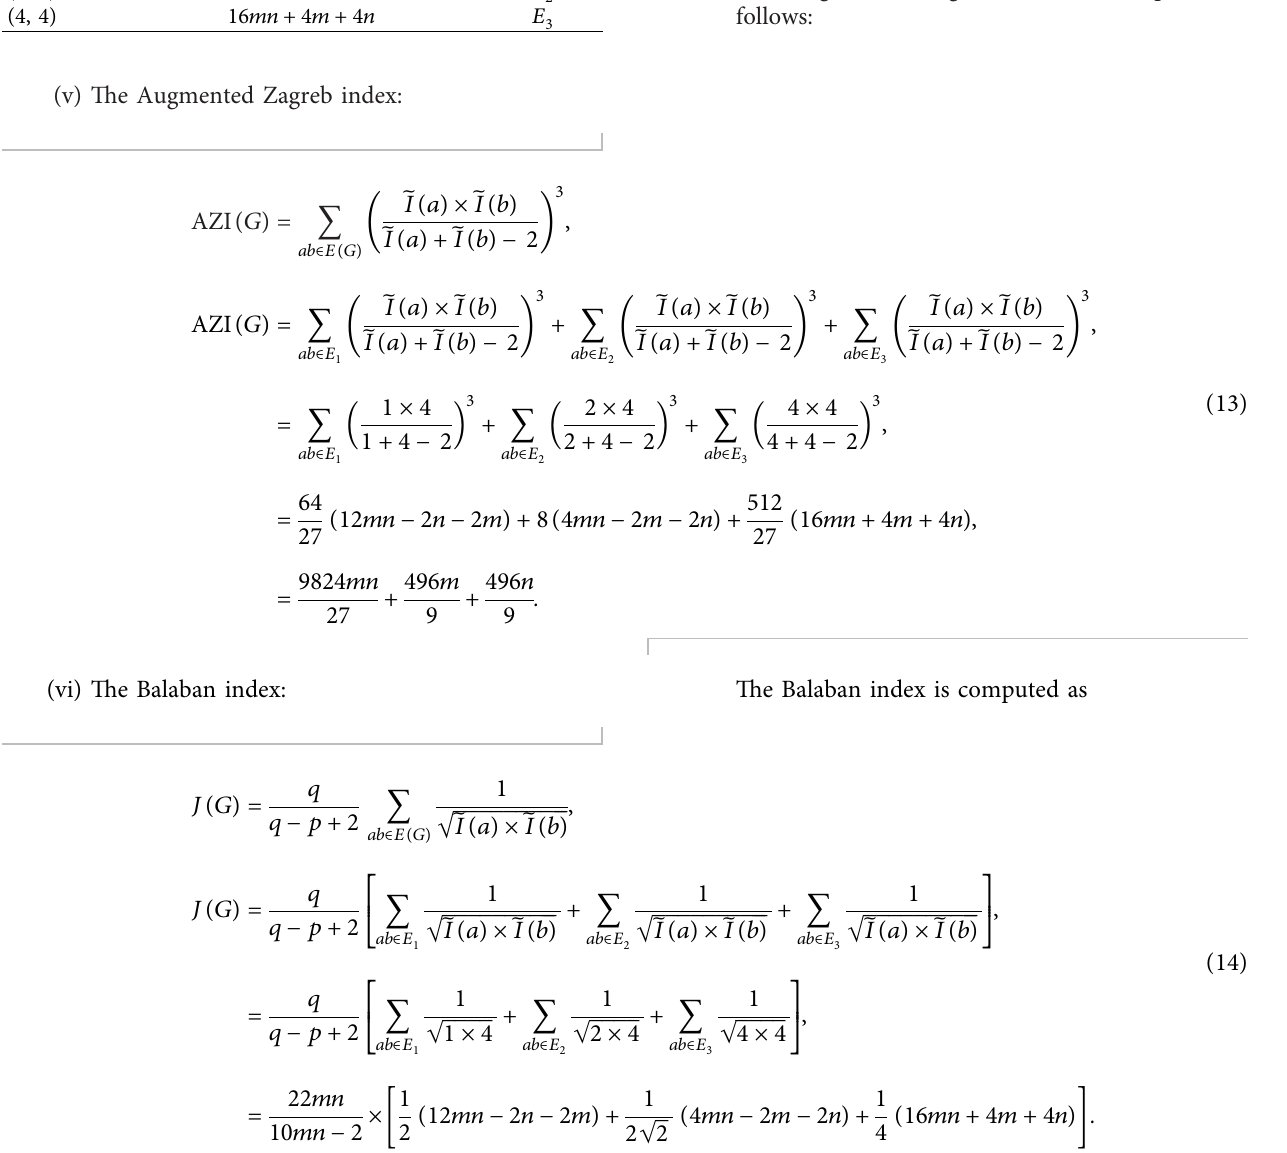
Table 3: Comparison of indices HM ( G ) , PM